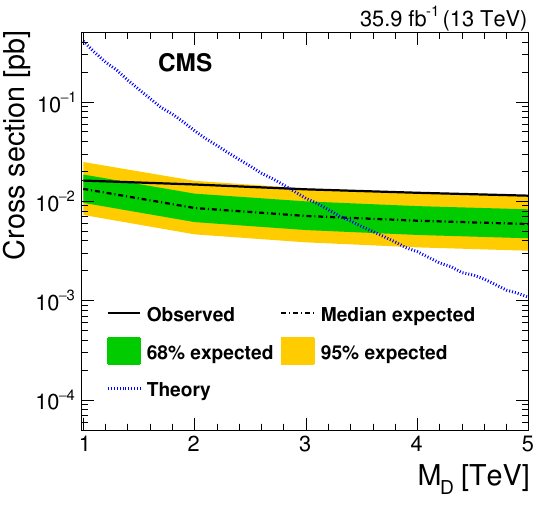
Figure 10 . The 95% CL upper limits on the ADD graviton production cross section as a function of M D , for n = 3 extra